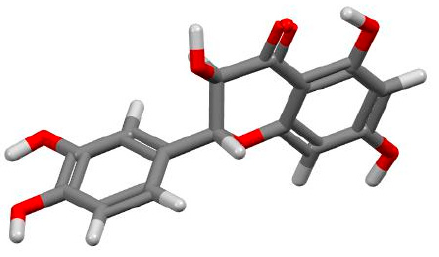
Table 1. Physical and chemical properties of taxifolin [38].